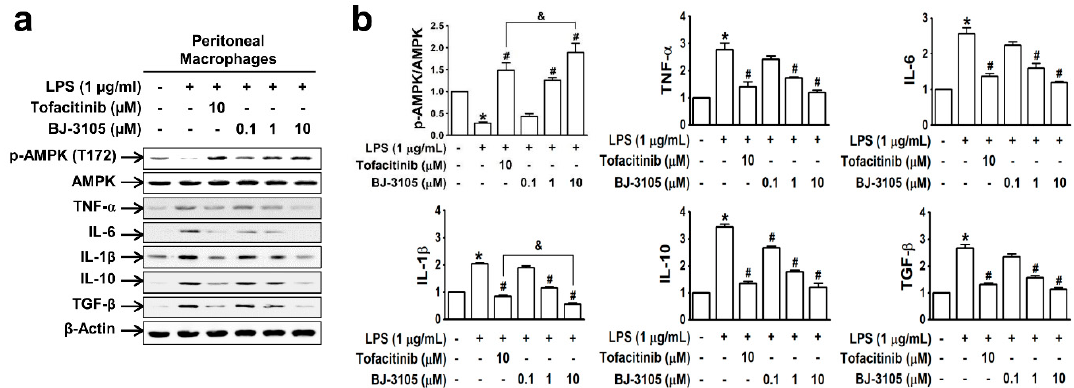
Figure 3. E ff ects of BJ-3105 and tofacitinib on LPS-induced AMPK activity and inflammatory cytokine expressions in peritoneal macrophages. ( a ) AMPK and inflammatory cytokine expression levels were analyzed by immunoblotting. ( b ) Bar graphs represent averaged quantitation of the immunoblots from at least three independent experiments. * p < 0.05, versus the vehicle-treated control group. # p < 0.05, versus the BW25113-treated group. & p < 0.05, versus the tofacitinib-treated group.